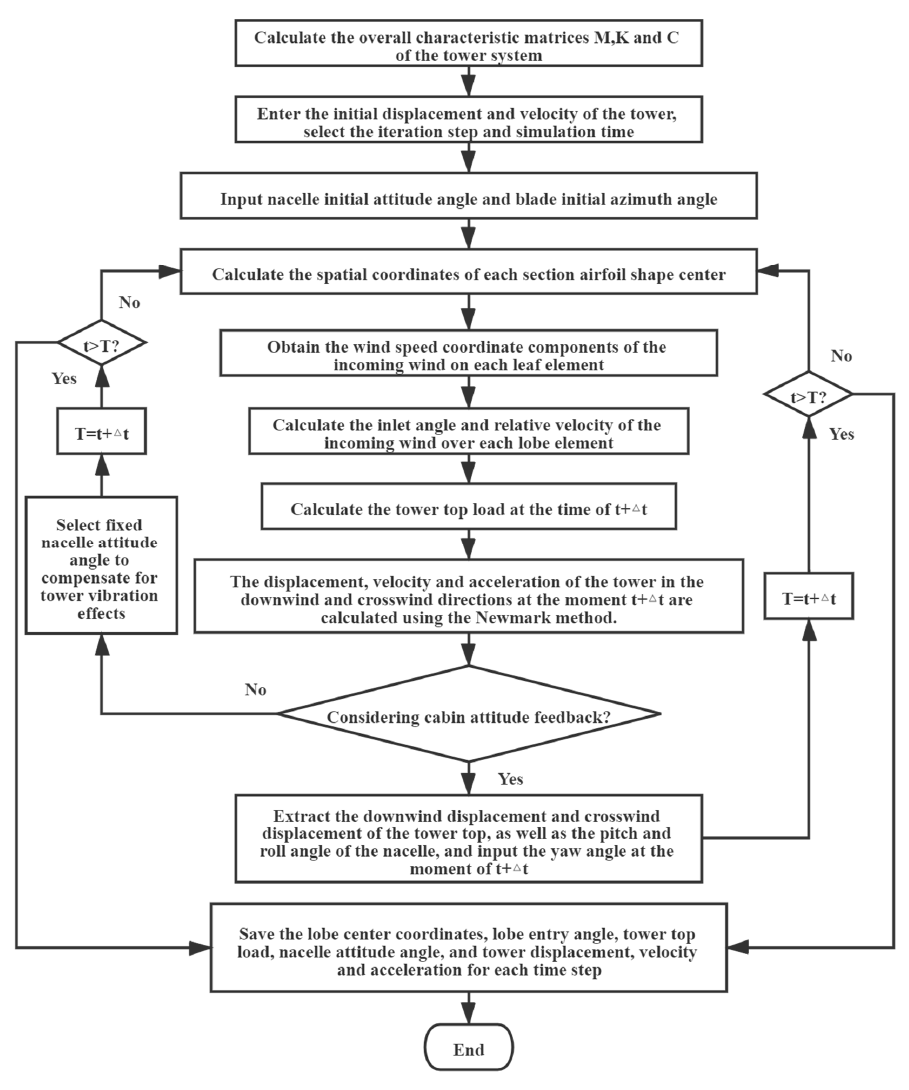
Figure 6. Dynamic response solving process of flexible tower.